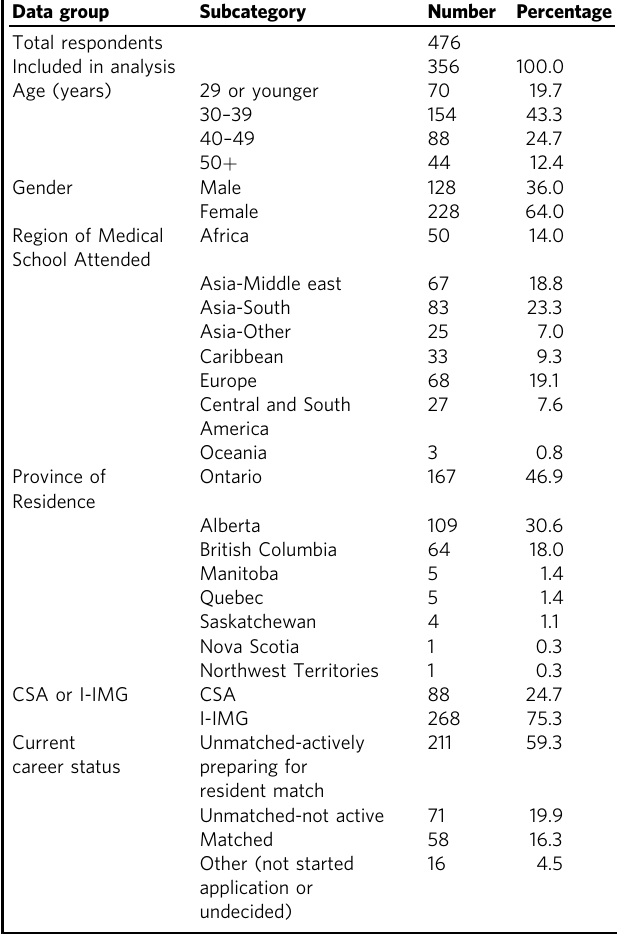
Table 1 Basic demographics of study